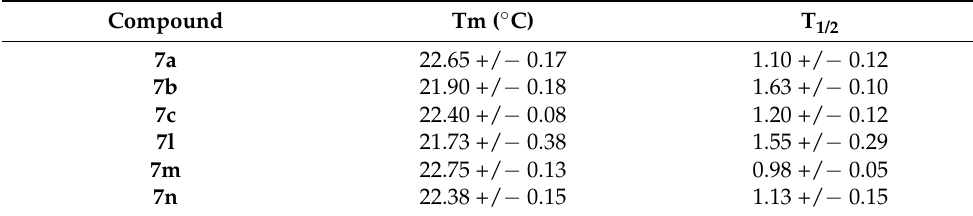
Table 3. The parameters of 1,2-dimyristoyl-sn-glycero-3-phosphocholine (DMPC) main phase tran- sition: temperature (°C) and peak width at half height for 0.1 compound:DMPC molar ratio.